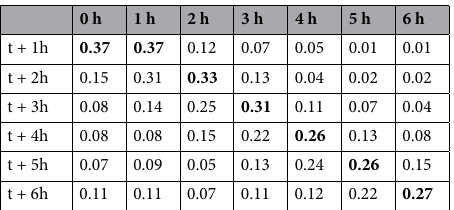
Table 4. The row-normalized fractions of the DTW measure for the network trained with the nominal data. Best results are in [bold].